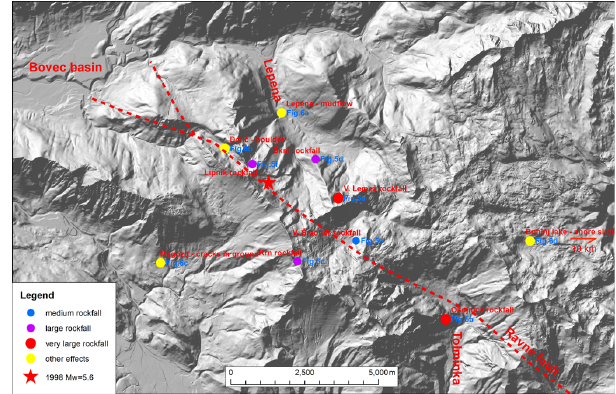
Fig. 3. Distribution of rockfalls caused by 12 April 1998 earthquake in Upper Soˇca valley with VII–VIII ESI 2007 isoseismal line.